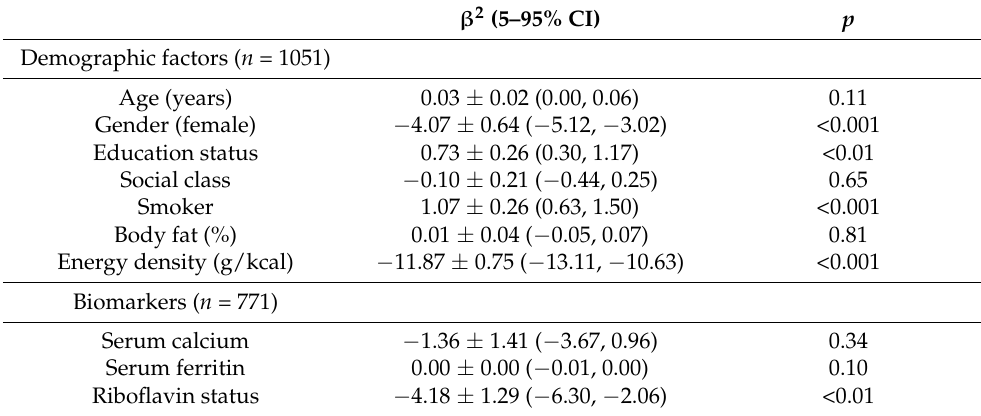
Table 2. Linear regression analysis of the PANDiet score with demographic and biofluid factors.